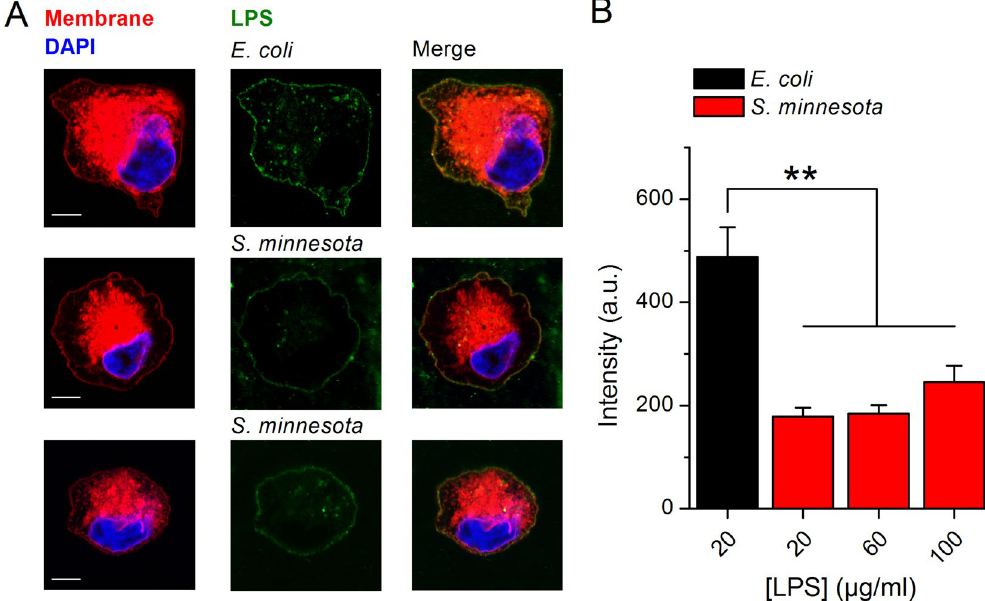
Figure 2. Spontaneous insertion of LPS from E . coli and S . minnesota into cellular membranes. ( A ) Representative Airyscan confocal images of CHO-TRPA1 cells stained with membrane mask (red), DAPI (blue) and treated with Alexa Fluor 488 LPS (green) from E . coli (20 µ g/ml top panel) or S . minnesota (20 µ g/ ml and 100 µ g/ml middle and bottom panel respectively). Scale bar, 5 µ m ( B ) Quantification of Alexa Fluor 488 intensity present in the cellular membrane after treatment with LPS. Data is shown as mean ± s.e.m. from at least 10 cells. ** P < 0.01, Mann-Whitney U test.